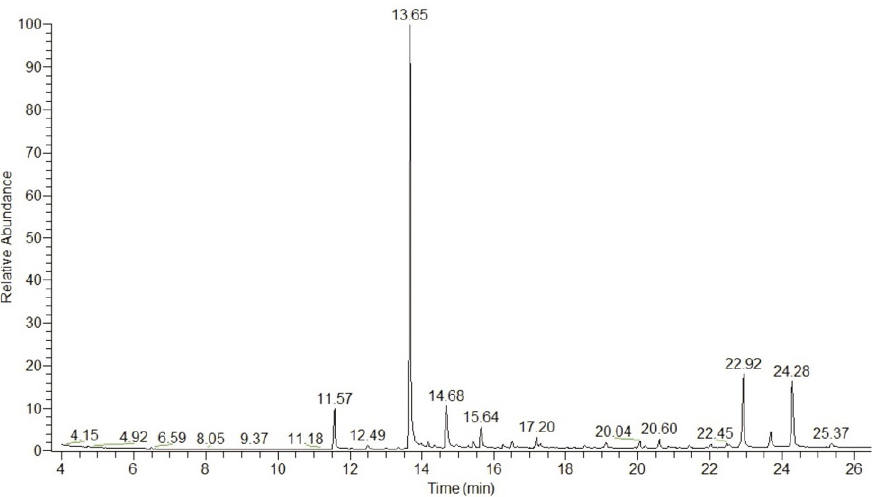
Figure 4. Chromatographic profile of P. pubescens oil present in the nanoemulsion stored at 5 °C for 180 d.